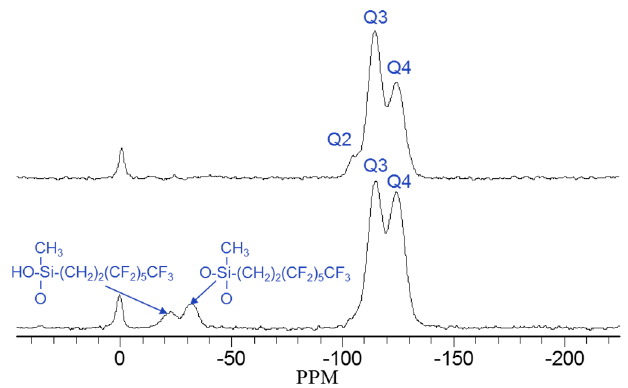
Figure 6. 29 Si solid-state NMR spectra of the fluorine-modified colloidal silica and unmodified silica (particle size: 12 nm).